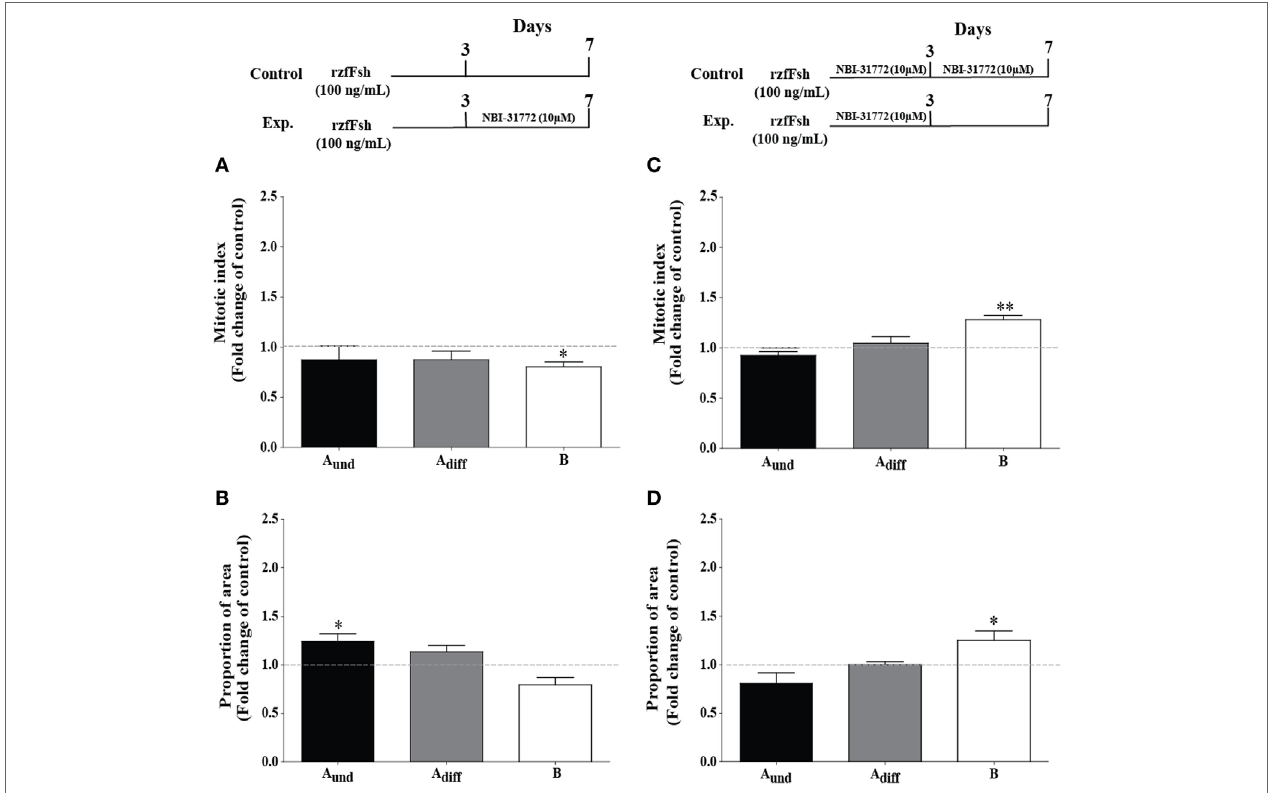
FigUre 6 | Effect of the presence (left panel) or absence (right panel) of an IGF binding protein inhibitor on follicle-stimulating hormone (Fsh)-stimulated spermatogonial proliferation and proportion of area after 7 days of primary testis tissue culture. (a) Mitotic indices and (b) proportion of area occupied by cysts containing type A und , type A diff , and type B spermatogonia in the presence of Fsh (100 ng/mL) for 7 days (control group, represented by stippled line) or 3 days in the presence of Fsh (100 ng/mL) and the remaining 4 more days in the additional presence of 10 µM NBI-31772 (experimental group); a schematic representation of the experimental setup is shown in the upper left panel ( n = 6). (c) Mitotic indices and (D) proportion of area occupied by cysts containing type A und , type A diff , and type B spermatogonia in the presence of Fsh (100 ng/mL) and 10 µM NBI-31772 for 7 days (control group, represented by stippled line) or 3 days under the same conditions and the remaining 4 more days in the presence of Fsh (100 ng/mL) only (experimental group); a schematic representation of the experimental setup is shown on the upper right panel ( n = 7). The production of biologically active steroids by Fsh was blocked by trilostane (25 µg/mL) in all cases. Results are presented as fold changes with respect to the control group. Asterisks indicate significant differences (* P < 0.05; ** P < 0.01) between